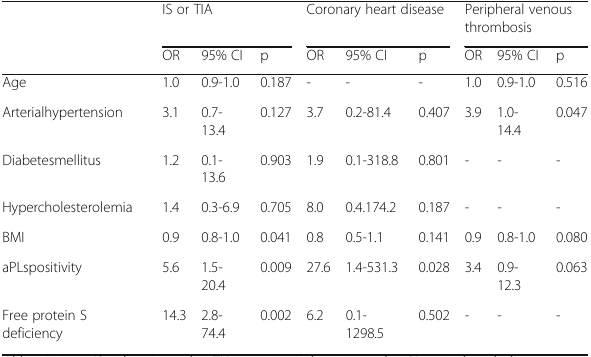
Table 1 (abstract P145). Risk of ischemic stroke or transient ischemic attack, heart disease, and peripheral venous thrombosis in migraine patients (multivariate